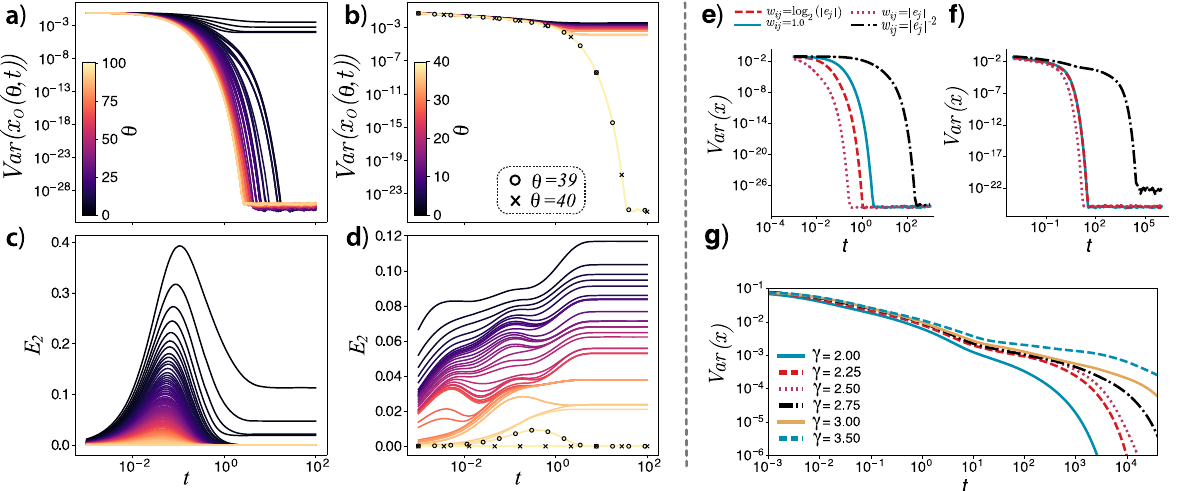
Fig. 5 Caracterization of diffusion on real and synthetic hypergraphs. a – c Represents real hypergraphs, while e – g synthetic ones. a , b The variance of states, x O ( θ , t ), up to order θ , in the diffusion, while c and d display the error E 2 , both as a function of time and structures considered, θ (color-coded). To represent the hypergraphs, we used in a and c , a power-law distribution of cardinalities, whereas in b and d , the hypergraph is given by the real email data (see text). The three panels to the right ( e – g ) show results obtained for weighted diffusion on hypergraphs, in terms of the variance of the state of the complete system x , de fi ned by Eq. (43). e , f The effect of the different weights as a function of the cardinality, Eq. (2), see the legend. e Corresponds to a synthetic hypergraph with a power-law distribution of cardinalities, P ( ∣ e ∣ ) ~ ∣ e ∣ − 2.05 , and f to the email hypergraph. g Explores the dependency with the exponent of the power-law weighting